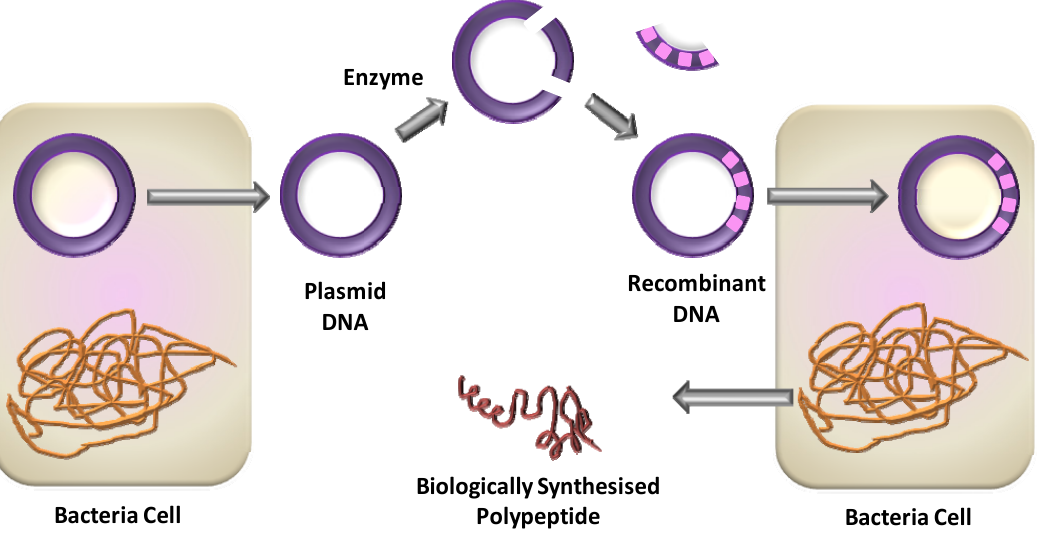
Figure 2. Recombinant DNA technique for protein synthesis. Redrawn from